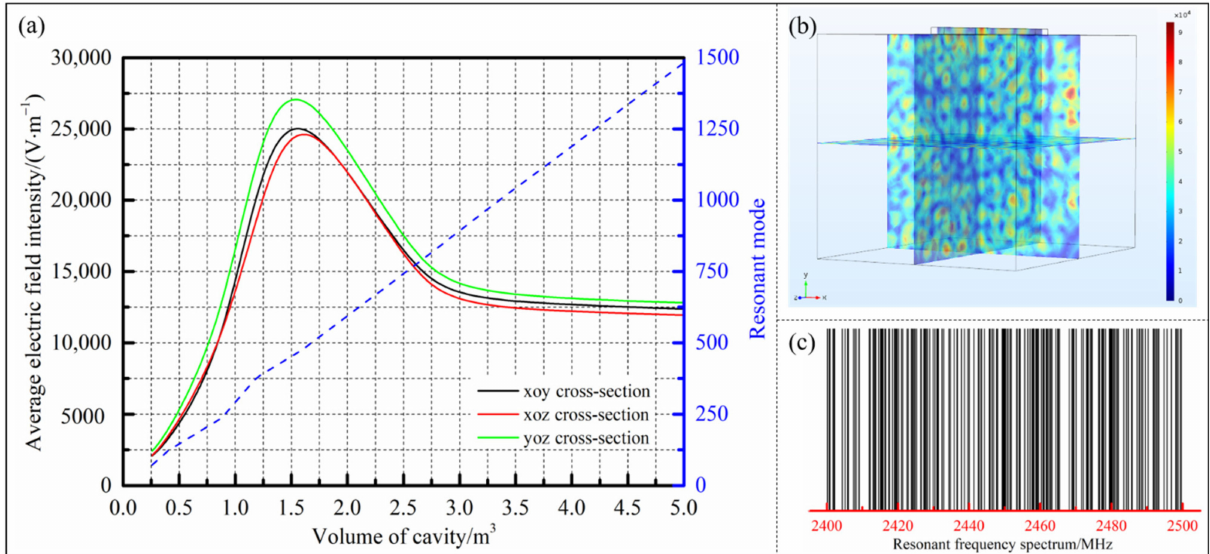
Figure 2. ( a ) The relationship curves of the resonant modes and the average electric field intensity with the volume of cavity; ( b ) the electric field distribution under the critical volume; ( c ) the existing resonant frequency spectrum in the cavity under the critical